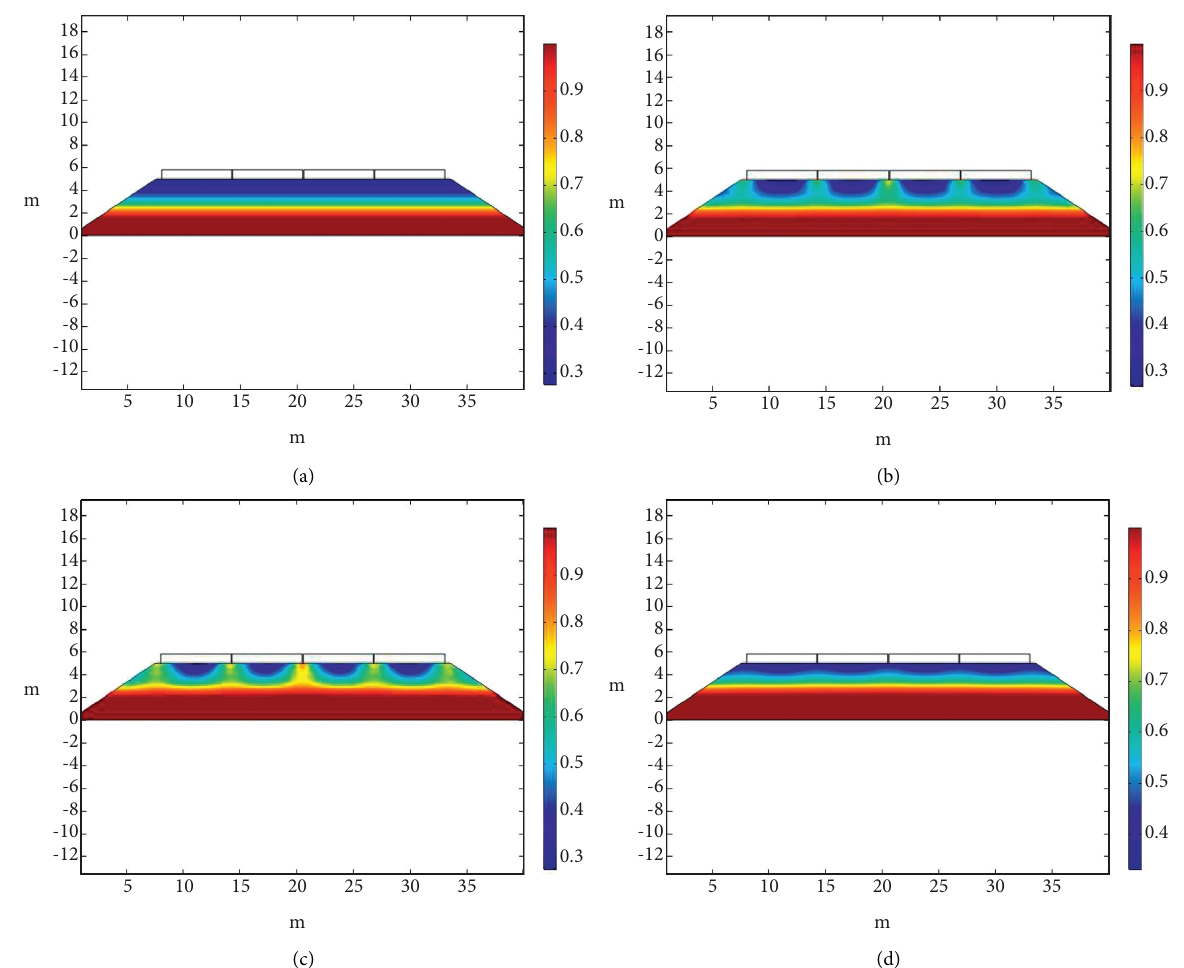
Figure 8: Shadow plot of the efective saturation of the unreinforced embankment at diferent times: (a) d � 0; (b) d � 2; (c) d � 4; (d) d �